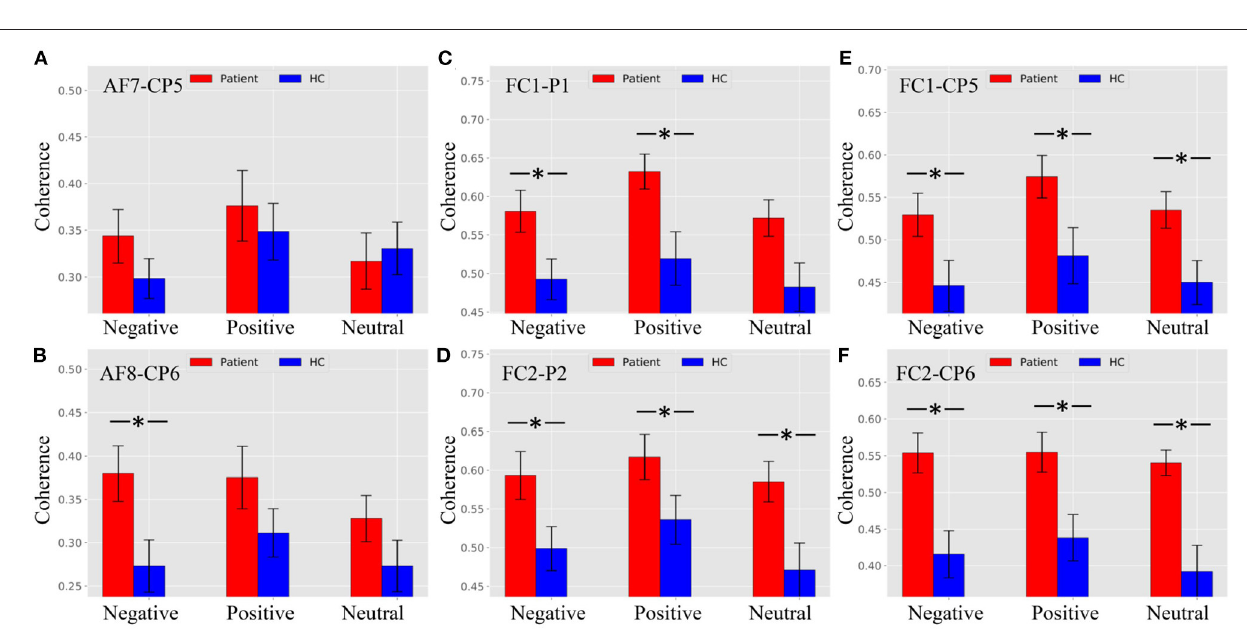
P2 (negative: r = 0.55, p = 0.012; positive: r = 0.52, p